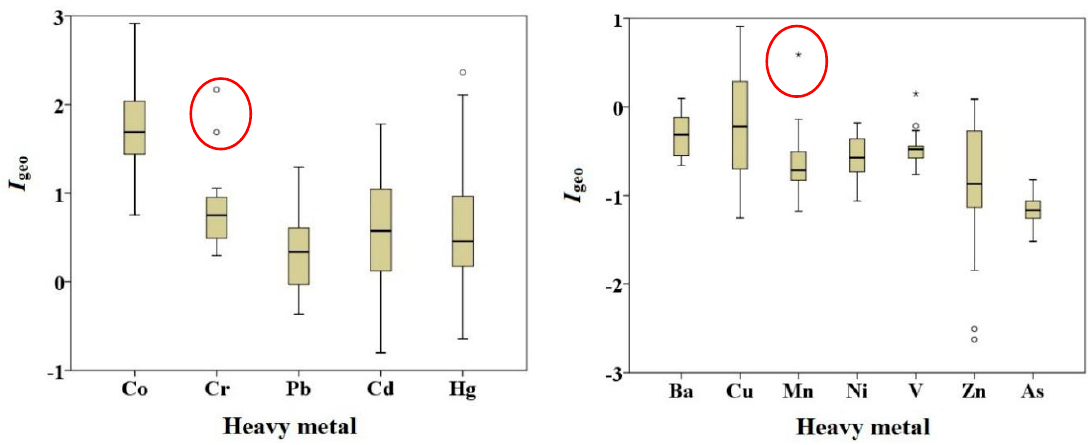
Figure 2. Box-plot of I geo for heavy metals in dust samples collected from parks and squares of Baotou (* extreme outlier; ° mid outlier).